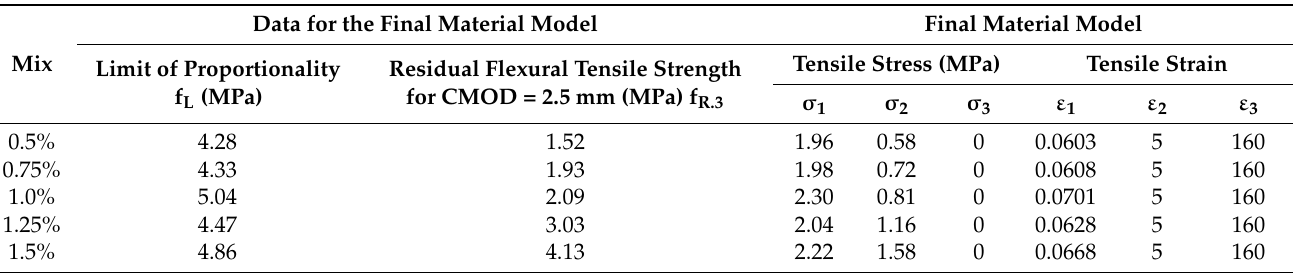
The strain ε 1 corresponding to the stress σ 1 was assigned with the assumption of the elastic behavior of FRC. In all fibers amounts, the strain ε 2 corresponding to the breaking point of the linear stress-strain relationship was estimated as 5%. The stress achieved 0 value for the strain equal to 160%. The final value of the parameters of the material model with the data from the laboratory investigation needed for their calculation are listed in Table 6. Table 6. The parameters of the final material model with the data from the laboratory investigation. Data for the Final Material Mix